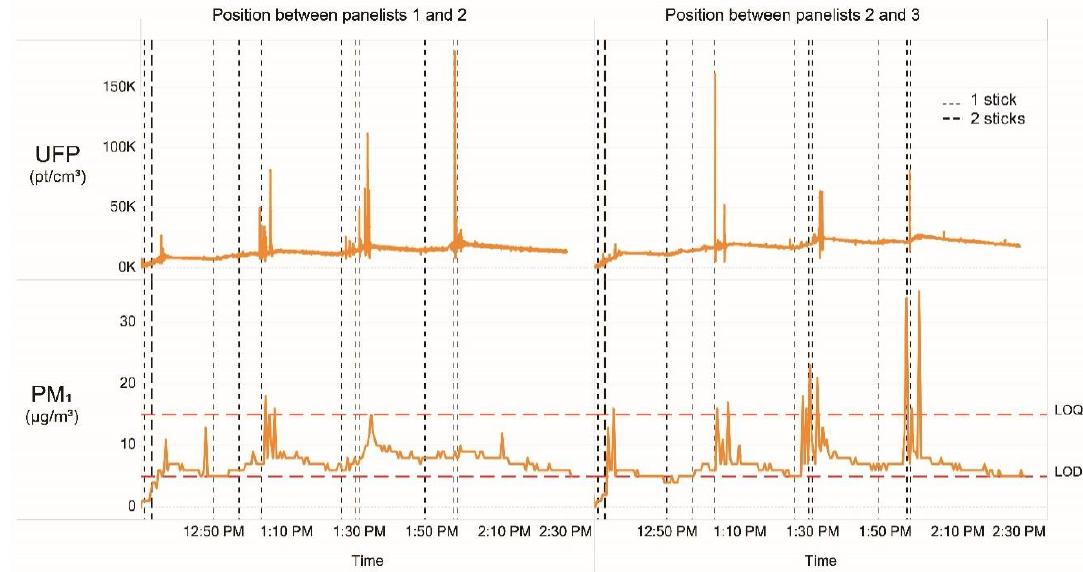
Figure 8. Comparison of airborne UFP and PM 1 (µg/m 3 ) traces in a typical session with THS 2.2 under the Residential category III simulated environment (0.5 h −1 ) against the time for consumption of the tobacco sticks (reprinted with permission from [17]). Note: for the positions of the panelists, refer to Supplementary Materials, Figure S2.